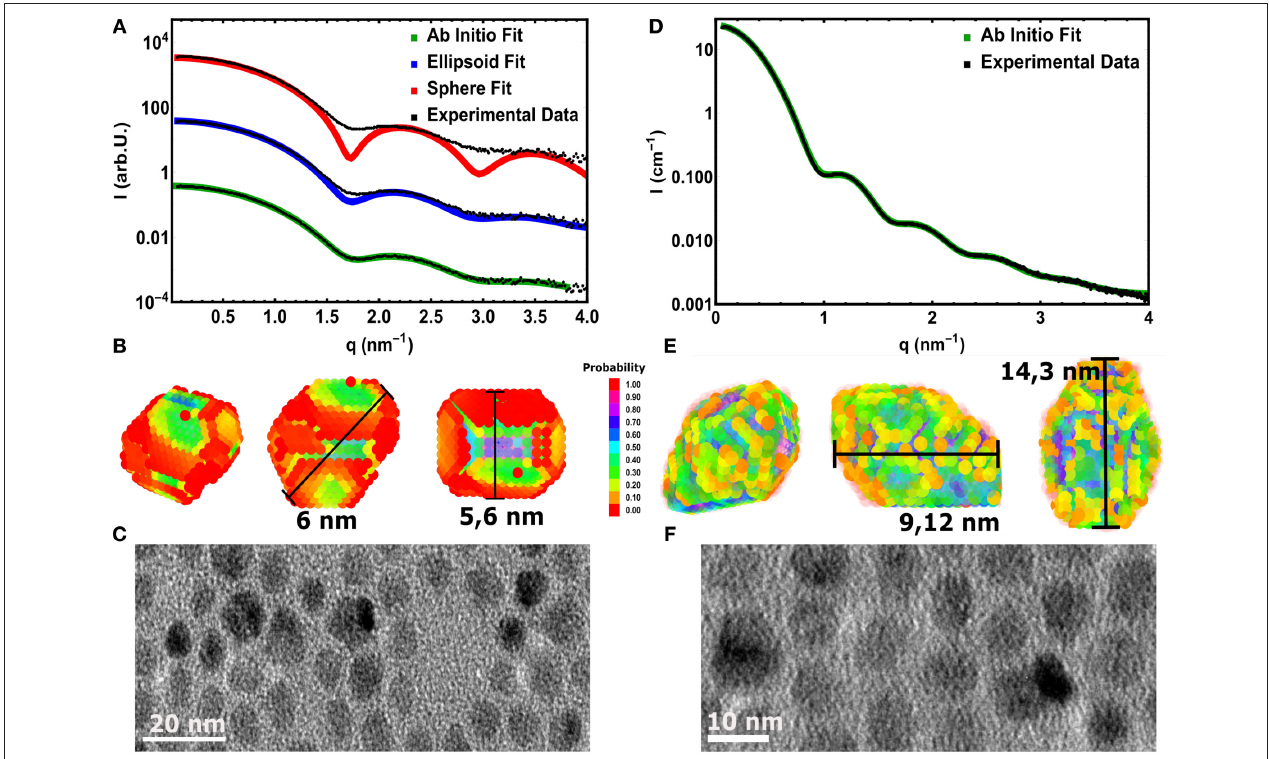
FIGURE 3 | (A) Experimental SAXS curve (symbols) of the large core CdSe NC-sample fitted with a spherical (red line) and an elliptical (blue lines) polydisperse shape model. The third fitting result (green line) is derived by a assumption free shape retrieval method using freely moveable dummy atoms with 0.5 nm in diameter (see B ). The line symbolizes the average of 5 independent fitting runs. (B) The resulting 3D mean shape as derived from the fits shown in (A) . The color represents the probability to find a single dummy atom at the same position after averaging 5 single shapes. The measurement bars show the found longest and shortest axes. (C) TEM image of the large CdSe cores revealing the surface facets in 2D projections. (D) Data (symbols) and fit (line) using the 3D shape retrieval for the large core/shell sample with the thickest shell. (E) The resulting 3D mean shape as derived from the fits shown in (D) , presenting pronounced surface facets and an elliptical shape with an aspect ratio of 1.7. (F) 2D TEM images of the large core/shell NCs measured in (D) .